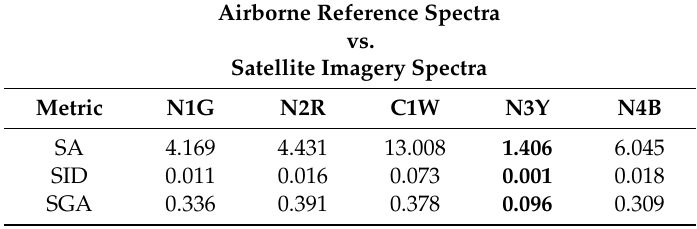
Table 4. Spectral similarity between the airborne target reference spectra and the space-borne target image spectra (SA is measured in degrees and SGA in radians). Values in bold are statistically